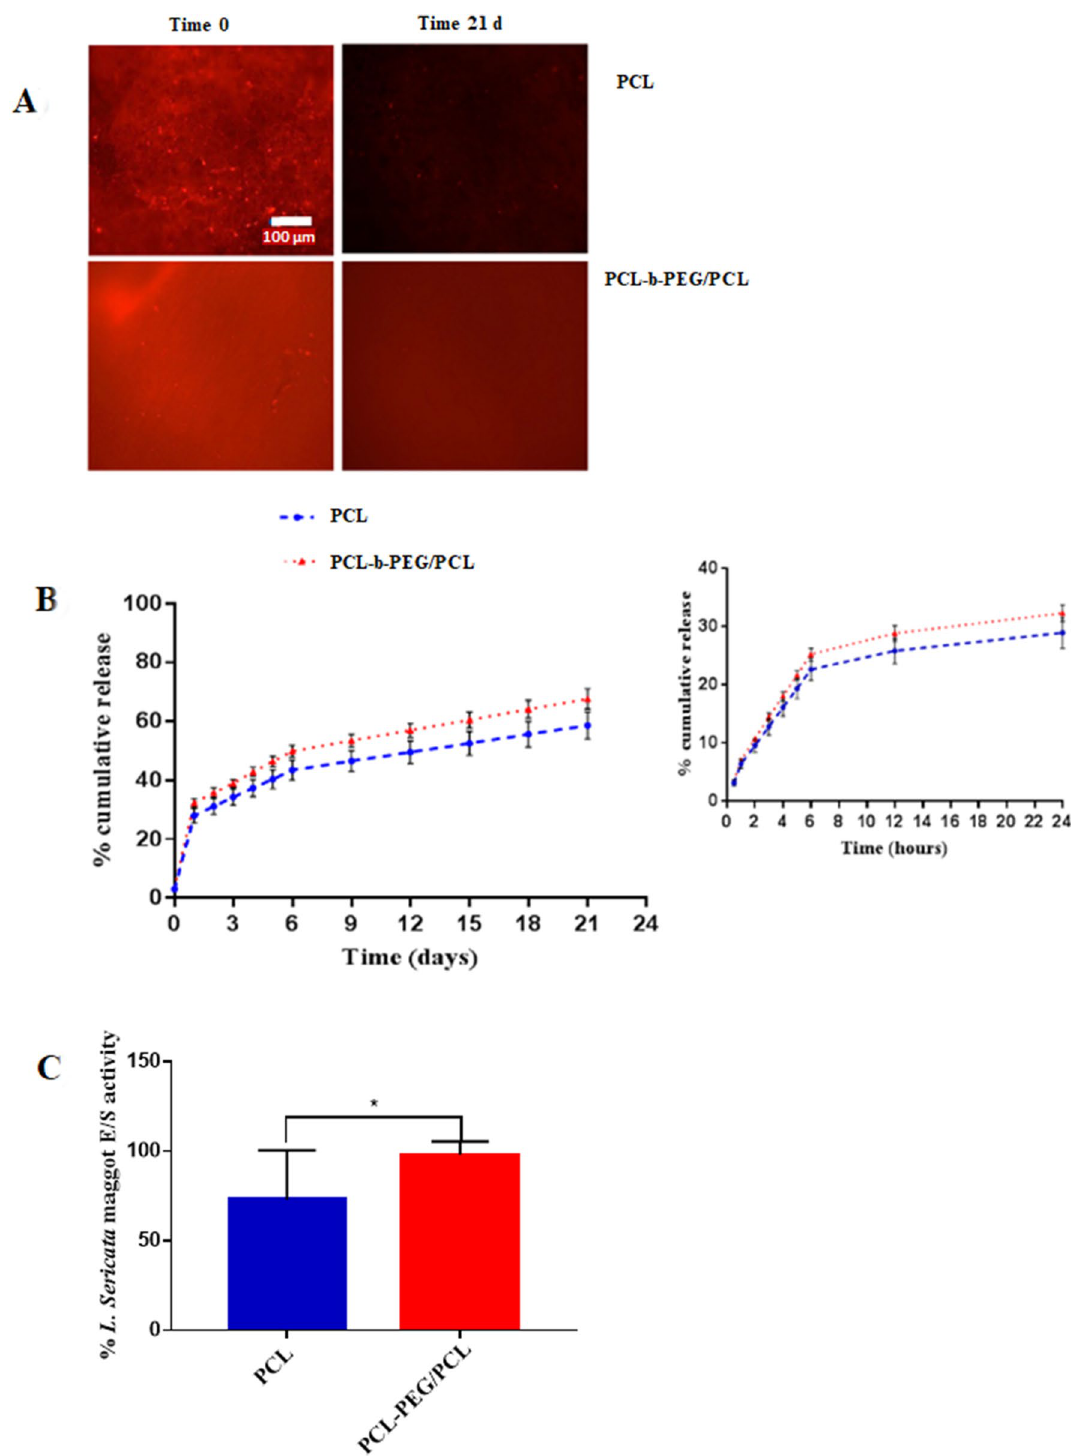
tive L. sericata maggot E/S activity. Maggot E/S release pooled frac- tion from PCL and PCL-b-PEG/PCL scaffolds were analysed using a protease assay. The data as L. sericata maggot E/S activity (%) nor- malised for protein content. Experiments carried out in triplicate, and three independent experiments (means ±